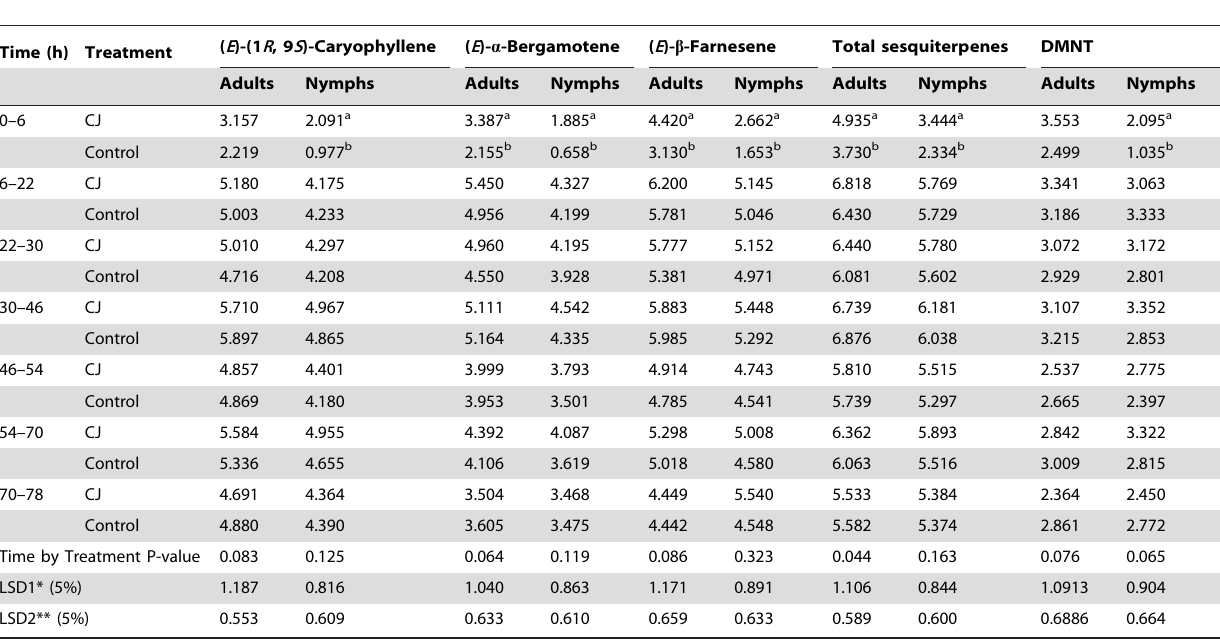
Table 2. Mean quantities (log 10 ng) of sesquiterpene VOCs and DMNT emitted by maize ( Zea mays ) seedlings following either cis - jasmone (CJ) or control treatment and then addition of Cicadulina storeyi (adults, n =9 or nymphs, n =10) 24 h later.